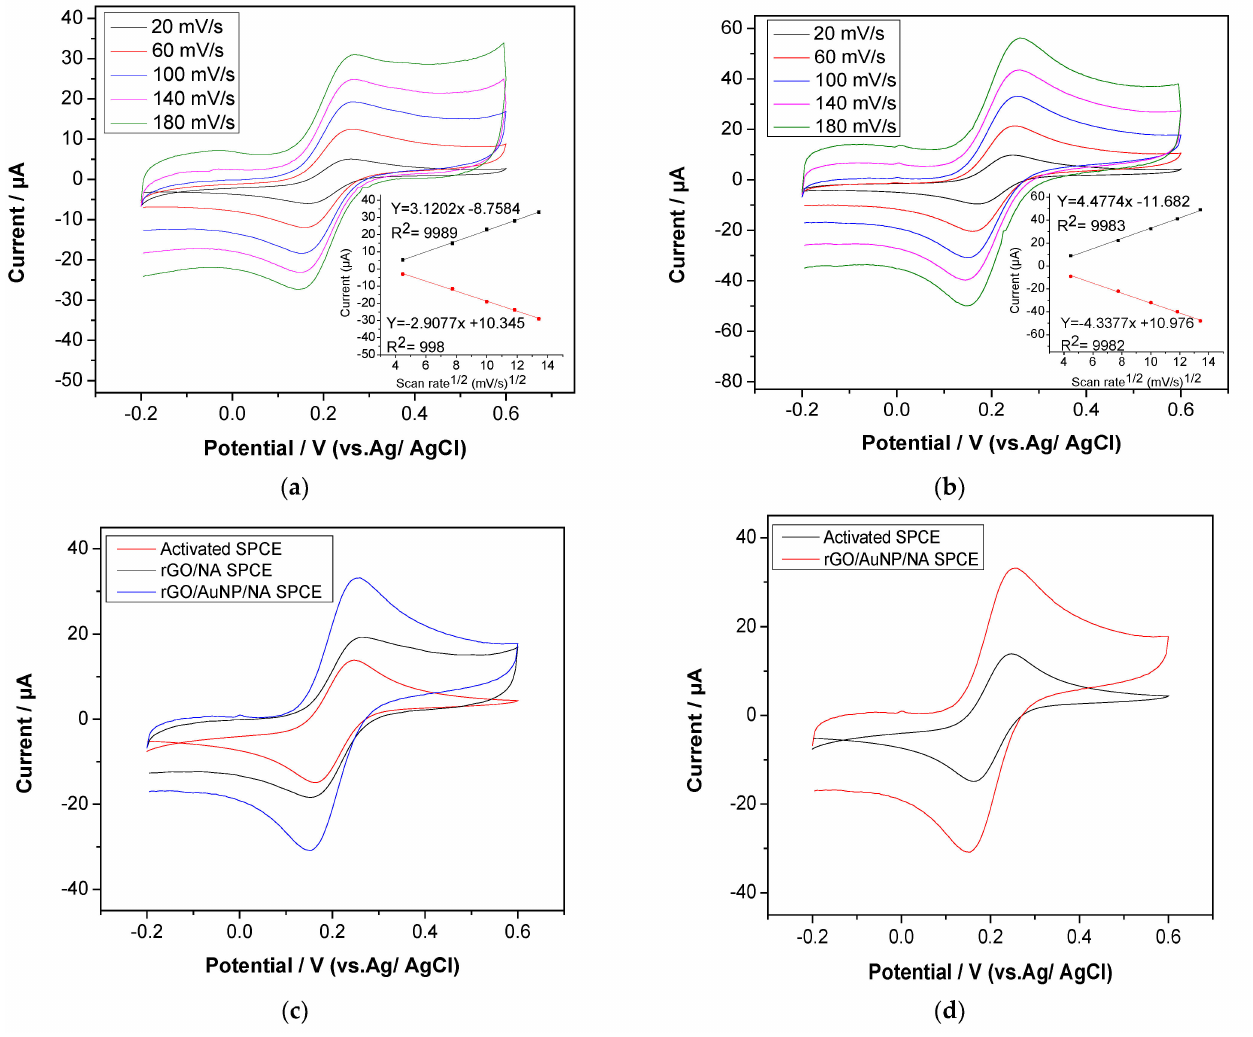
Figure 6. Cyclic voltammograms and plots of peak current vs. square root of scan rate (inset) for rGO/NA SPCE ( a ) and rGO/AuNP/NA SPCE ( b ) with various scan rates from 20 mV/s to 180 mV/s. ( c ) Cyclic voltammograms of activated, rGO/NA and rGO/AuNP/NA SPCEs at 0.1 scan rate. ( d ) Cyclic voltammograms of activated and rGO/AuNP/NA SPCEs at 0.1 scan rate: in 1 mM K 3 [F (CN) 6 ] in 0.1 M of